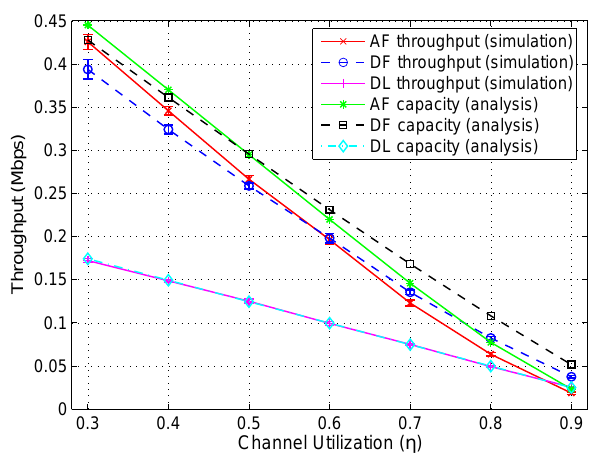
Figure 6. Throughput performance versus primary user channel utilization.